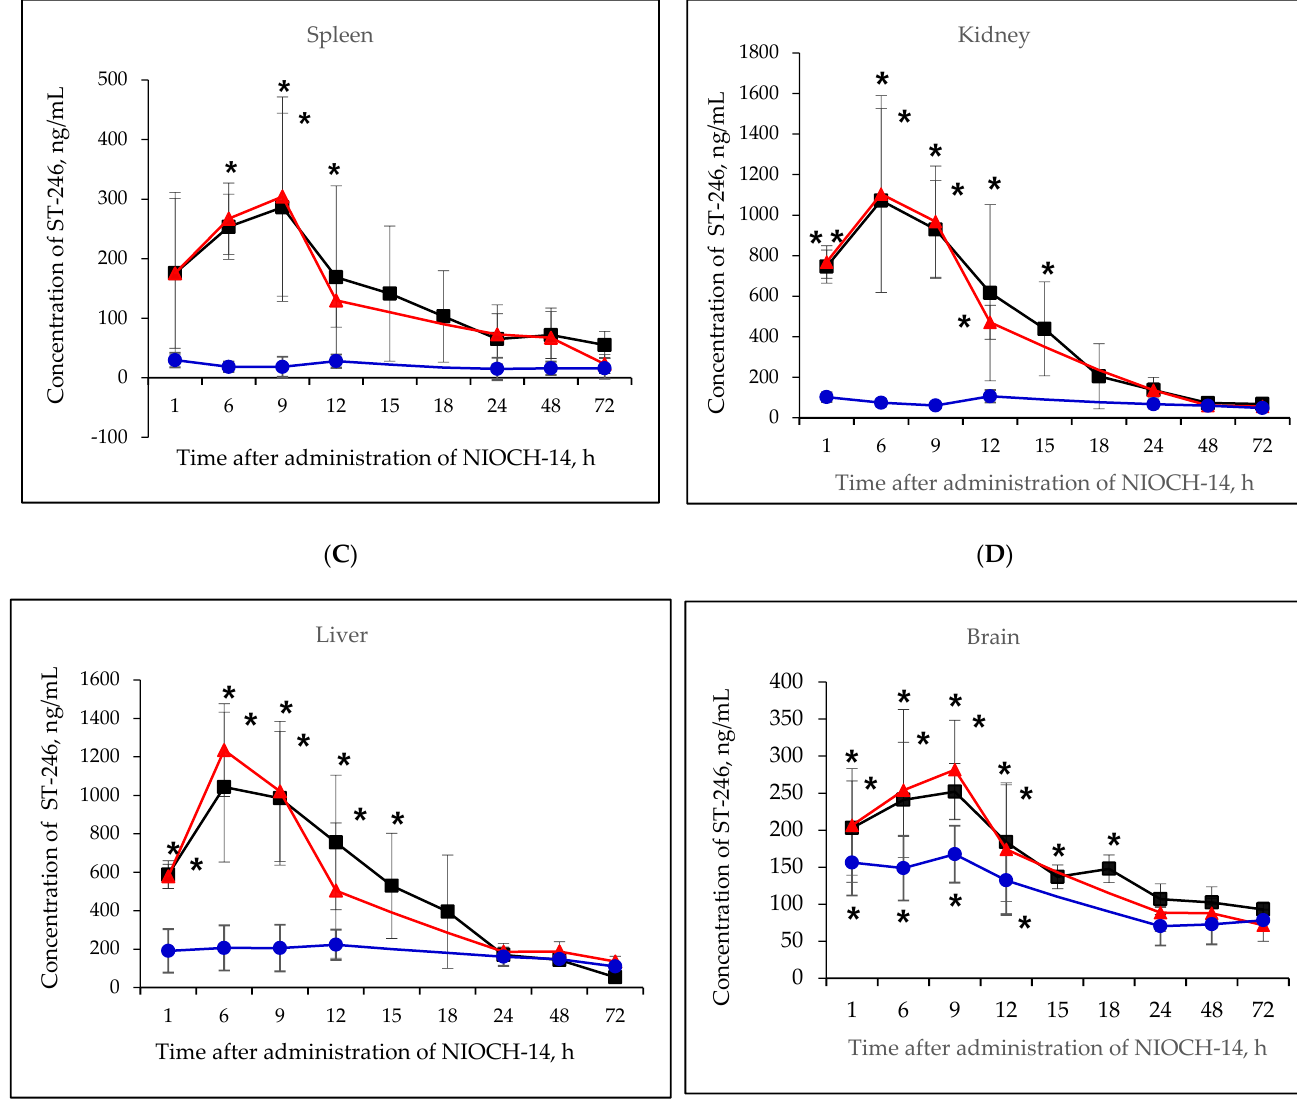
Figure 2. Changes in concentration of the active metabolite of NIOCH-14 (ST-246) in the mouse serum ( A ), lungs ( B ), spleen ( C ), kidneys ( D ), liver ( E ), and brain ( F ) after oral administration of the substance NIOCH-14. Single-dose administration of NIOCH-14 (50 µg/g body weight) ( ■ ). Administration of NIOCH-14 at a dose of 50 µg/g during 10 days ( ▲ ). Administration of NIOCH-14 at a dose of 5 µg/g during 10 days ( ● ). Values in each point are presented as M ± SD. * — the difference from the threshold level (50 ng/mL) according to the Student’s t -test at p ≤ 0.05. The pharmacokinetic parameters of ST-246 in mouse serum and tissue organs after single-dose oral administration of the substance NIOCH-14 (50 µg/g body weight) were parameters (T 1/2 , T max , C max , AUC 0-t , AUC 0-inf , and f T ) of the active metabolite ST-246 in mice (50 µ g/g body